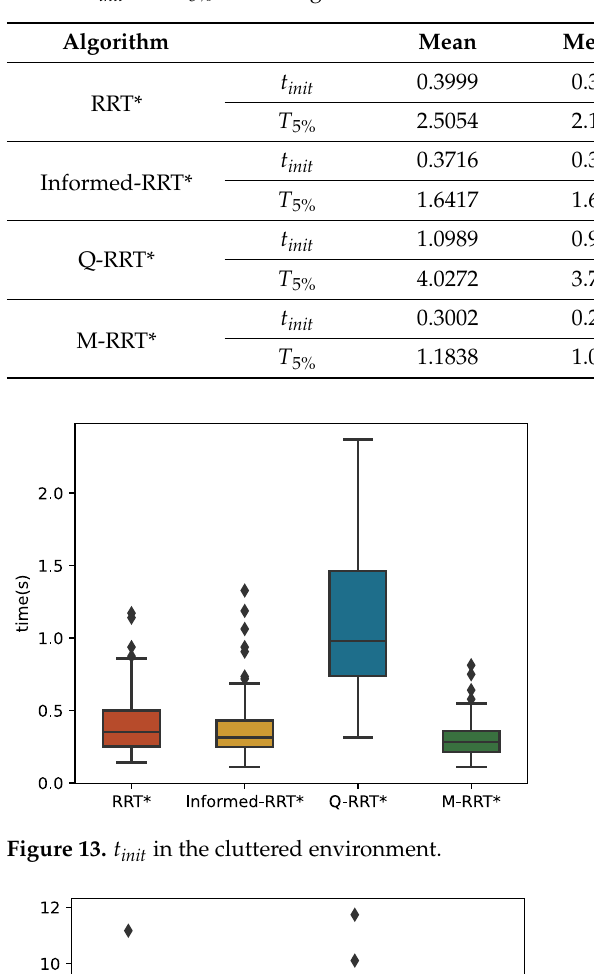
Figure 12. Performance of the four algorithms in the cluttered environment. ( a ) RRT*. ( b ) Informed- RRT*. ( c ) Q-RRT*. ( d ) M-RRT*. (Red line: approximate optimal path, green circle: goal region.) Table 3. t init and T 5% of four algorithms in the cluttered environment.